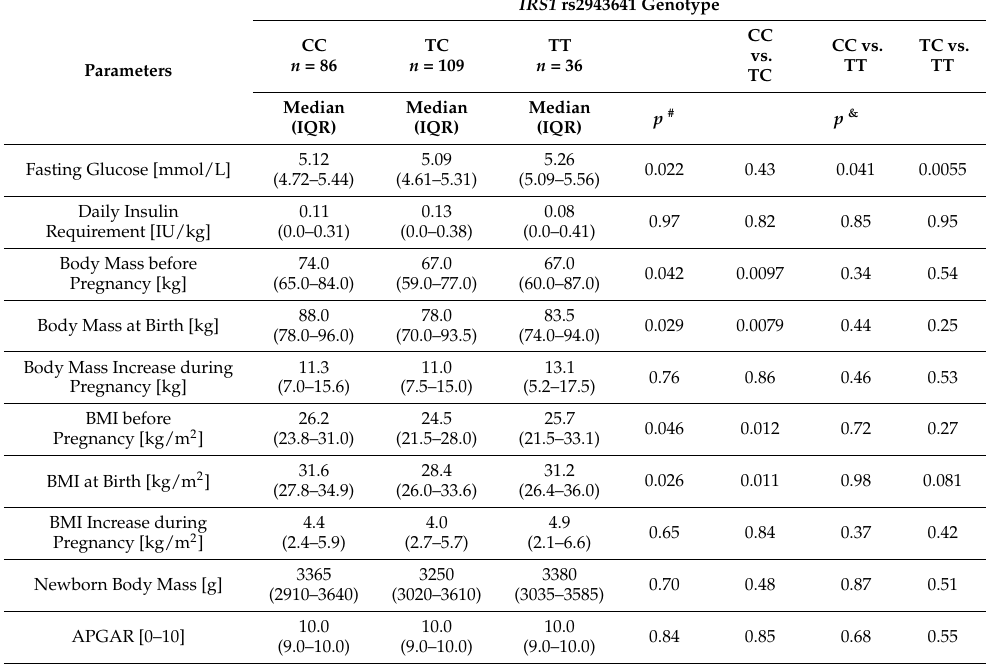
Table 3. Clinical parameters of women with GDM stratified according to IRS1 rs2943641